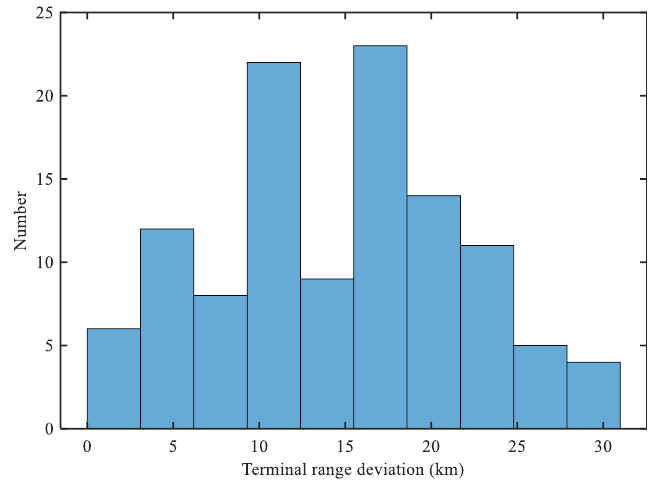
Figure 30. Monte Carlo experiment drop point distribution.